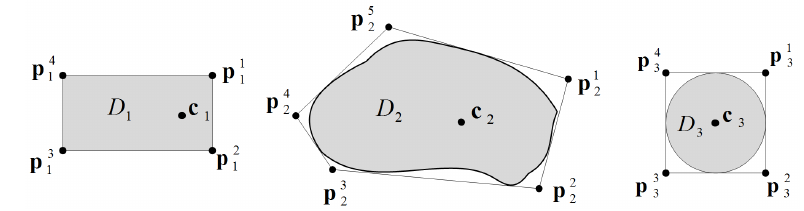
Figure 2. Models of regular- and irregular-shaped network